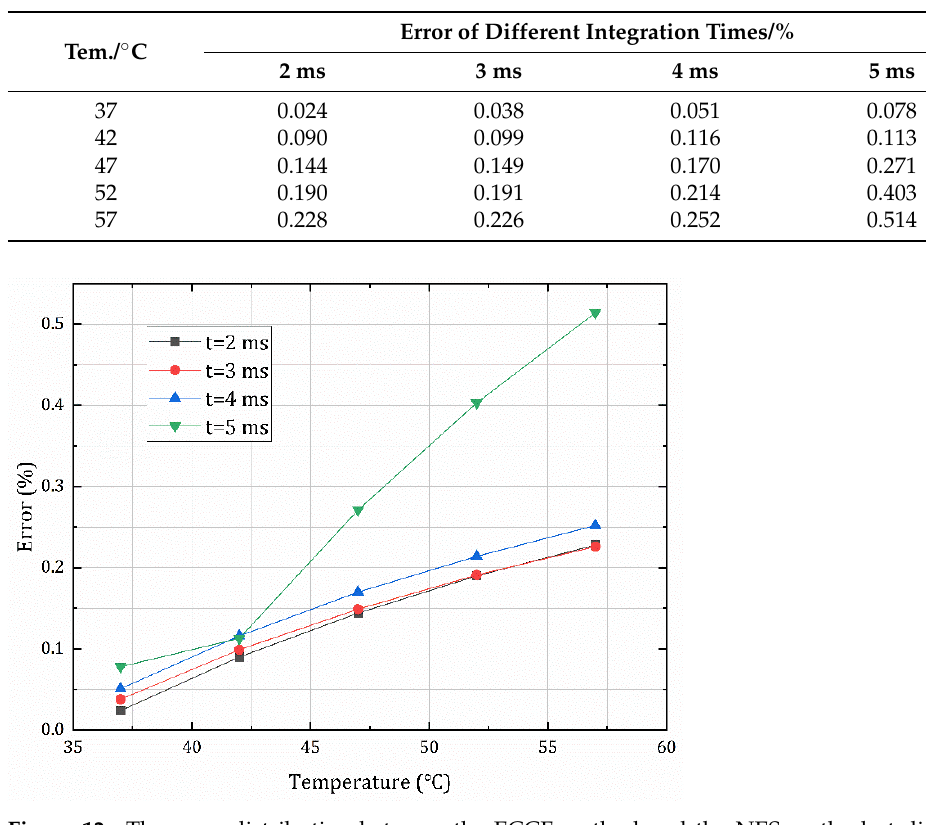
Figure 12. The error distribution between the ECCF method and the NES method at different integration times.